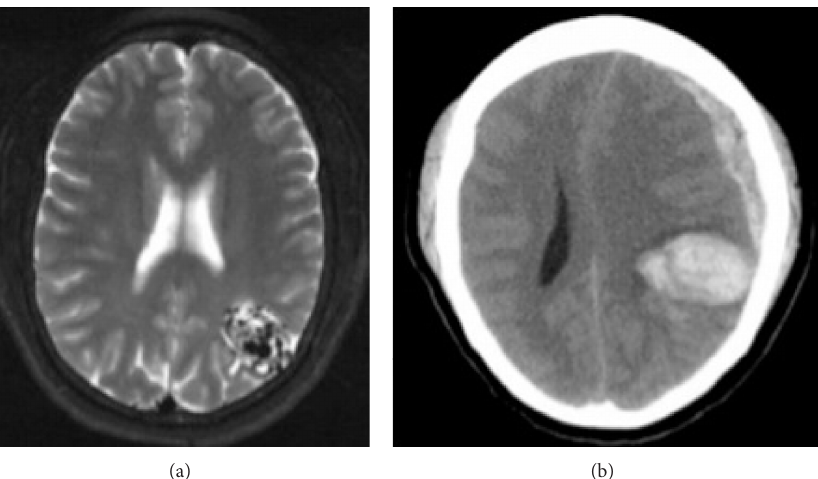
Figure 1: (a) Axial T2 MRI demonstrating left parietal AVM extending from the posterior horn of the left lateral ventricle to the cortex of the left parietal lobe; (b) axial CT demonstrating left parietal ICH and frontoparietal SDH. There is approximately 1.2 cm of left-to-right midline shift.